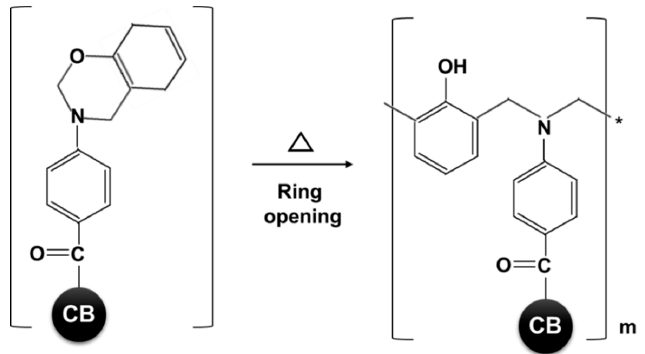
Figure 7. Schematics of ring-opening reaction of the benzoxazine groups in BZCB during annealing.